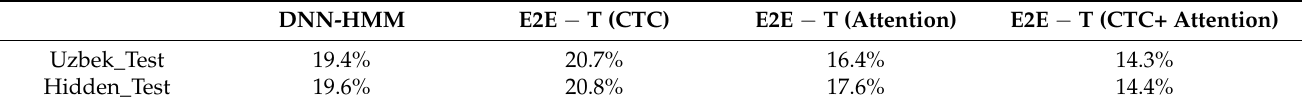
Table 5. The results of the study were obtained using the Uzbek_Test set and the Hidden_Test set, analyzing the WER performance (%) for the E2E transformer (E2E − T) with CTC, Attention, and Attention + CTC, and